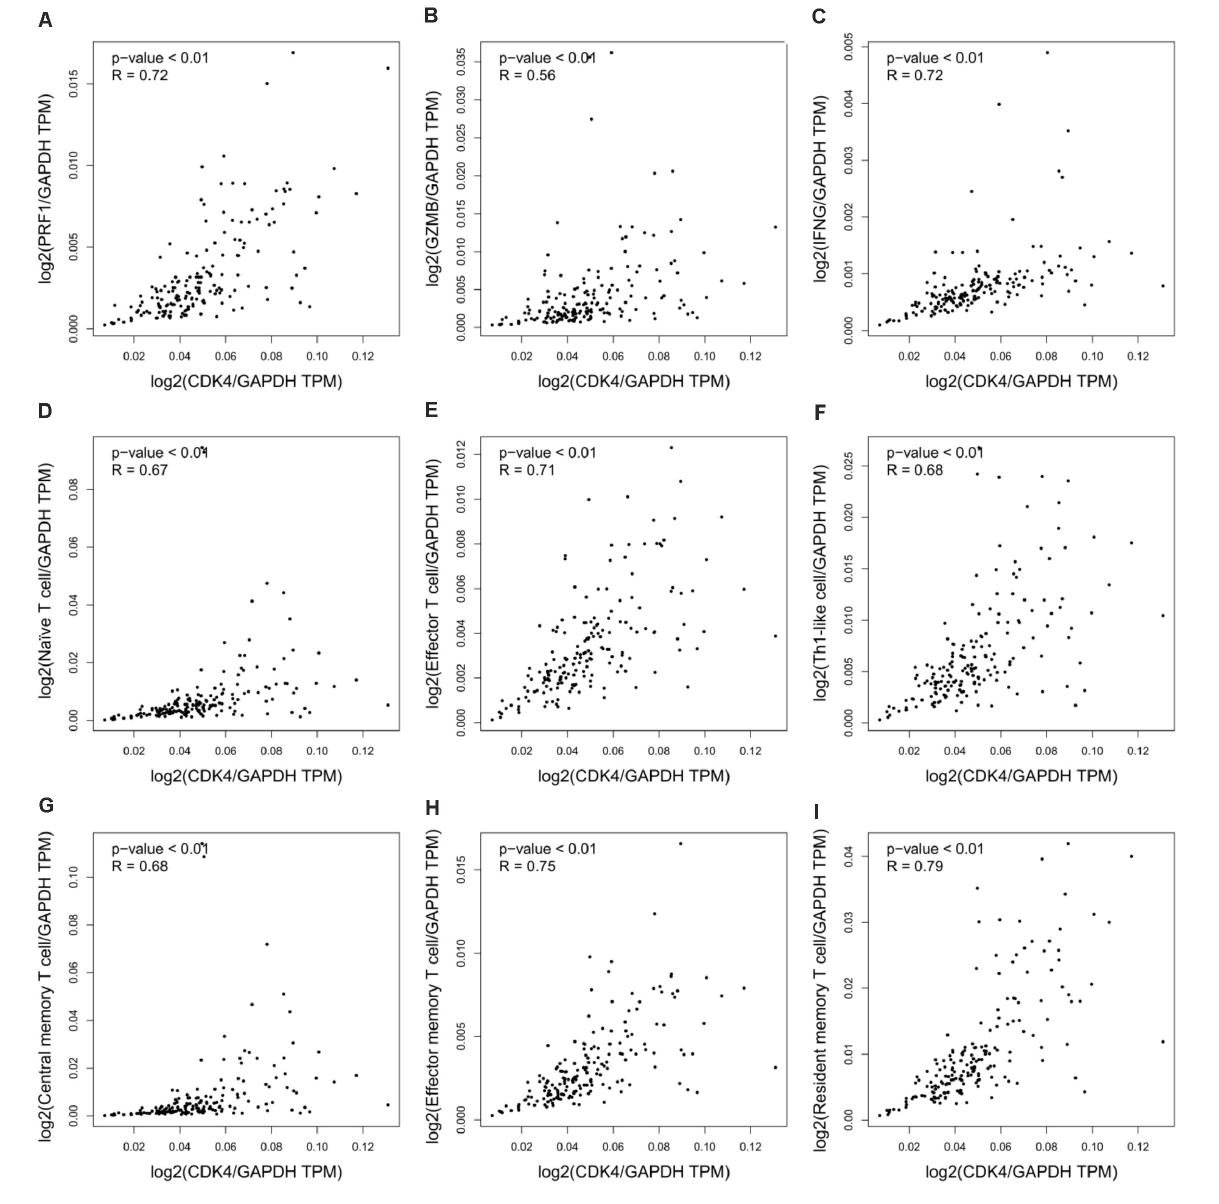
FIGURE 1 | CDK4 correlates with immune regulation in pancreatic cancer. (A–C) Correlation analysis of CDK4 and the immune effector molecules PRF1 (A) , GZMB (B) , and IFNG (C) in PAAD. (D–I) Correlation analysis of CDK4 and immune cell signatures in PAAD, including naïve T cell signatures (D) , effector T cell signatures (E) , Th1-like cell signatures (F) , central memory T cell signatures (G) , effector memory T cell signatures (H) , and resident memory T cell signatures (I) . P -values ≤ 0.05 were considered statistically